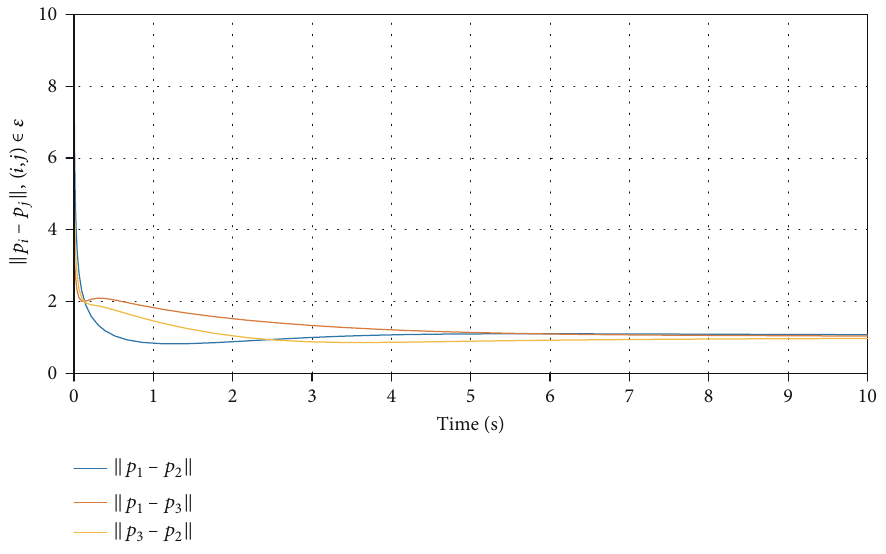
Figure 6: Distance errors.